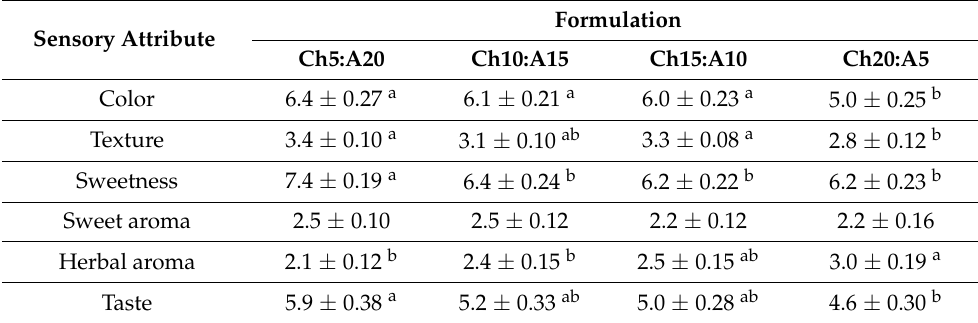
Table 5. Sensory evaluation of different formulations of